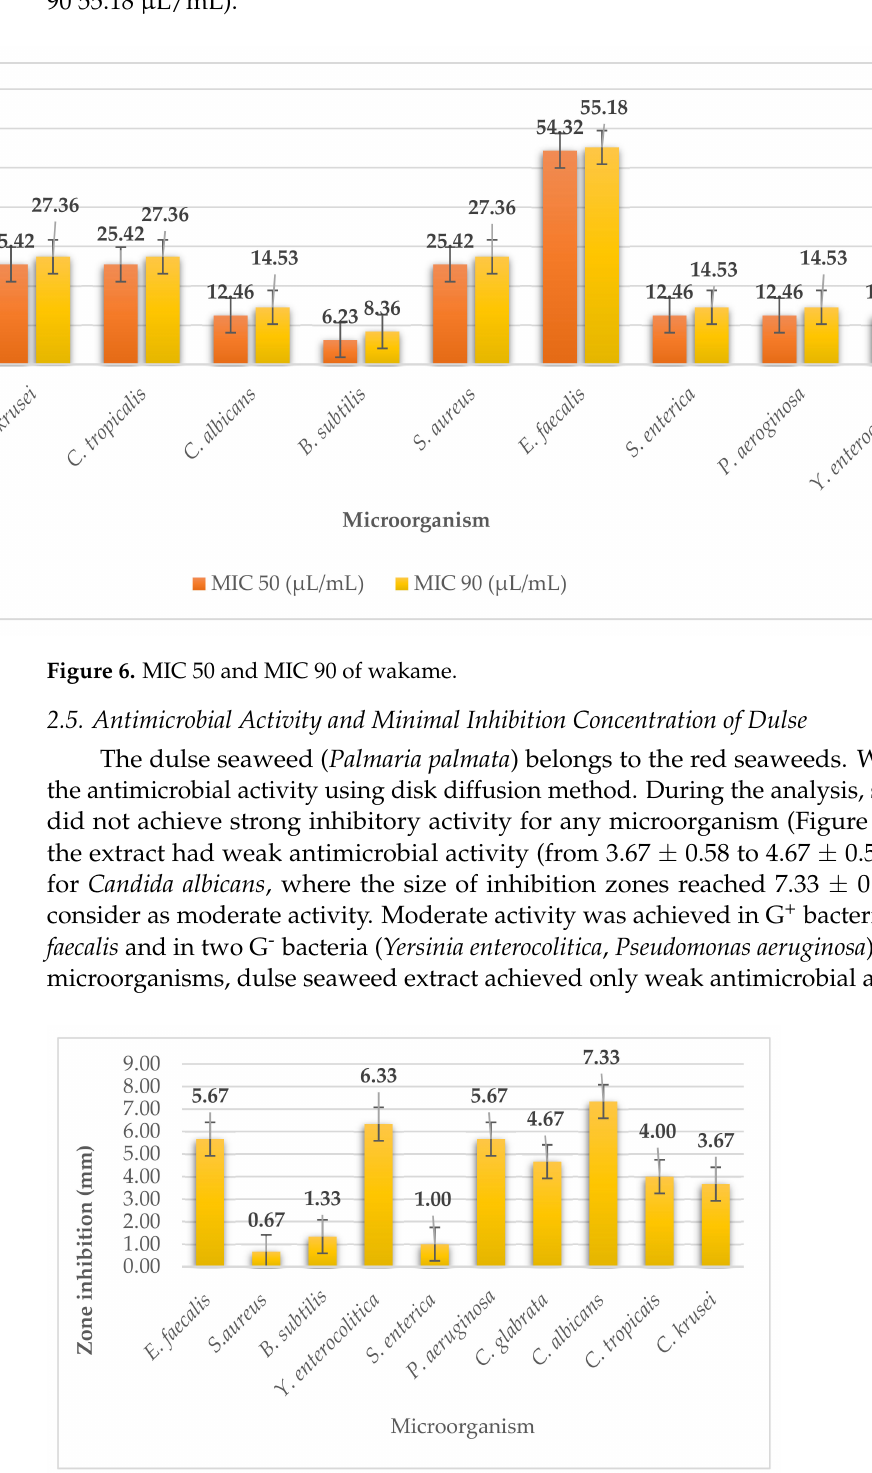
Figure 7. Antimicrobial activity of